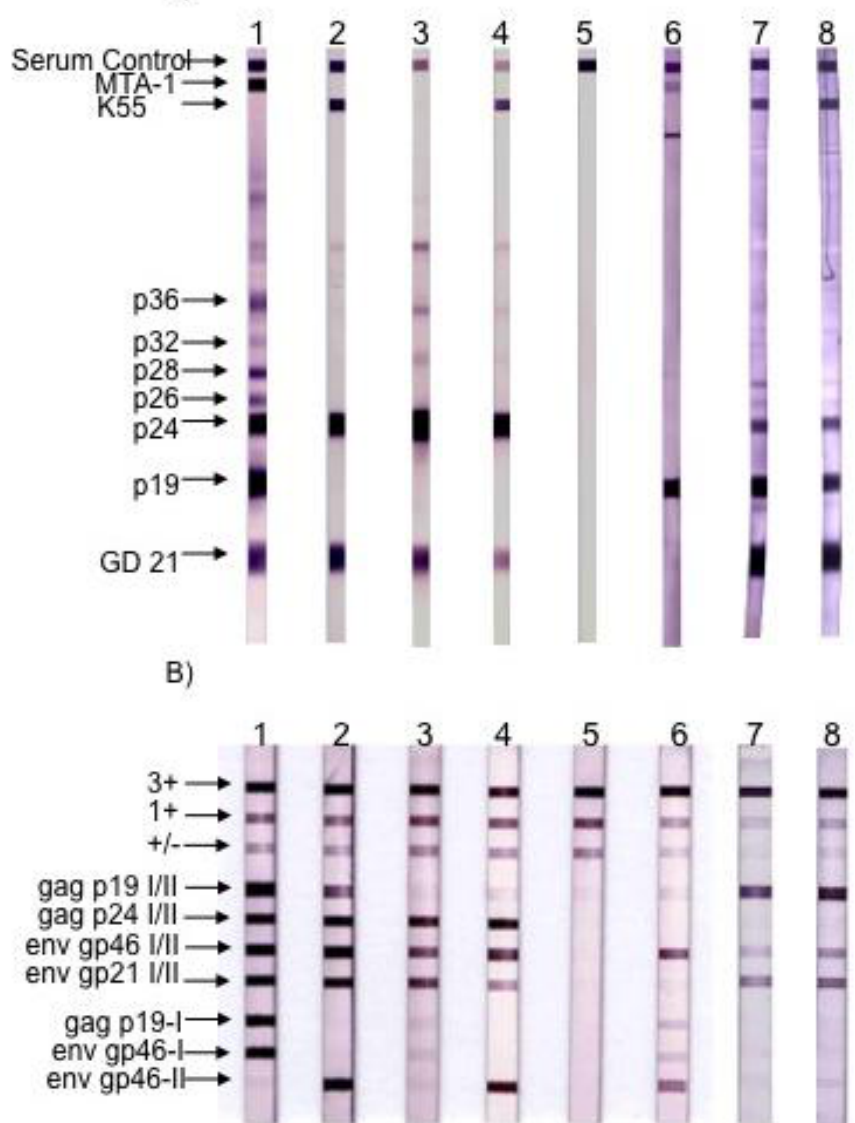
Figure 4. Serological pattern of HTLV-1, HTLV-2, STLV-3 and HTLV-3